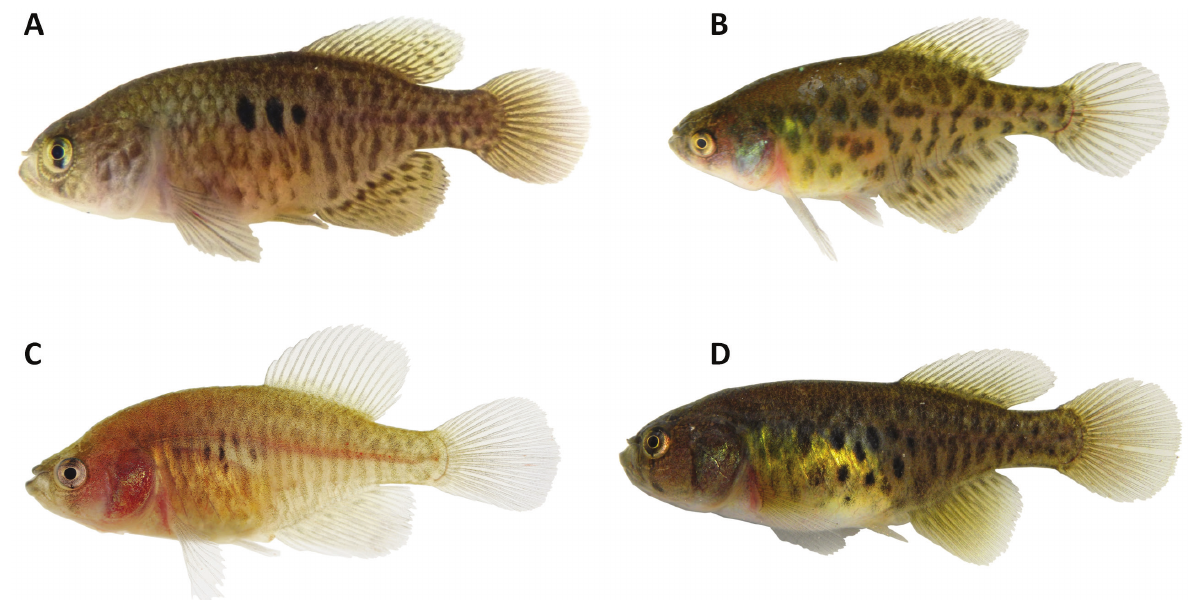
Figure 3. A. Austrolebias queguay sp. n. female: paratype ZVCP 11620; B. A. bellottii female (ZVCP 11560); C. A. univentripinnis female (UFRGS 18066); D. A. melanoorus topotype female (ZVCP